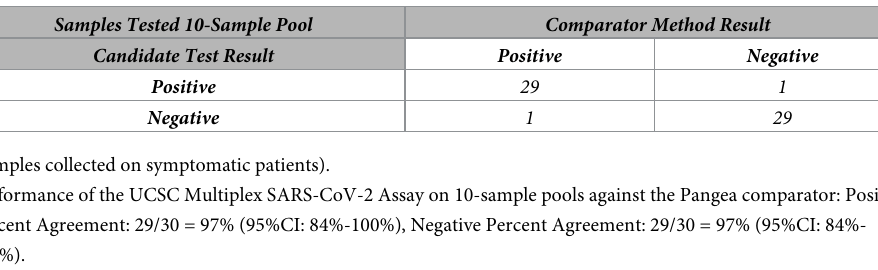
Table 4. Validation of UC Santa Cruz Multiplex SARS-CoV-2 assay by a commercial lab using true positive and true negative pooled surveillance samples. Samples Tested 10-Sample Pool